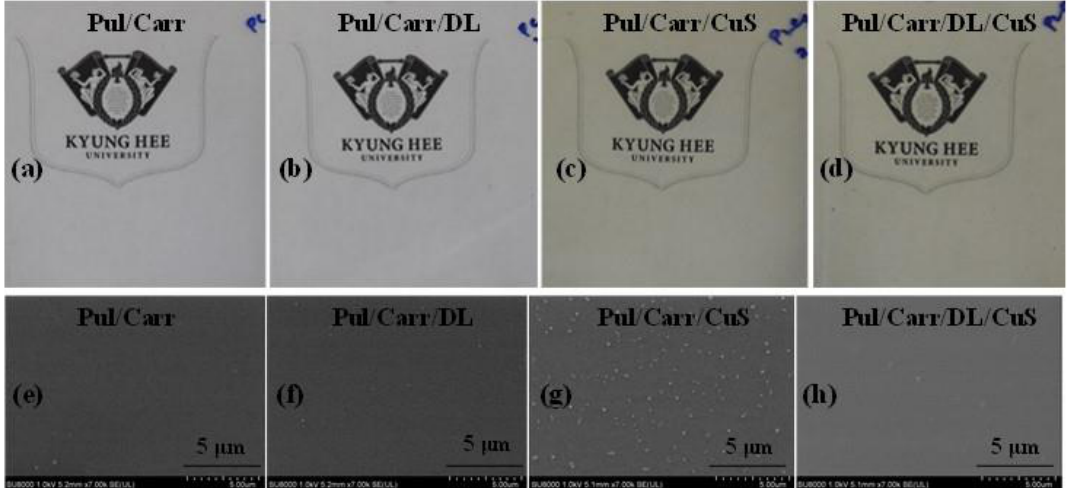
Figure 1. The visual appearance ( a – d ) and microstructure ( e – h ) of the pullulan / carrageenan-based films.